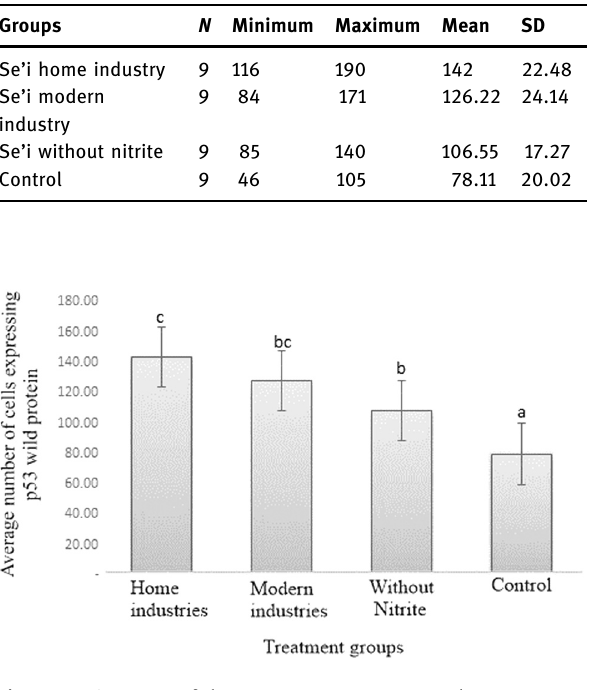
Figure 2: Histogram of the treatment group versus the average number of cells expressing the wild - type p53 protein ( note: the same ab superscript shows no di ff erences between groups [ based on the LSD test ])